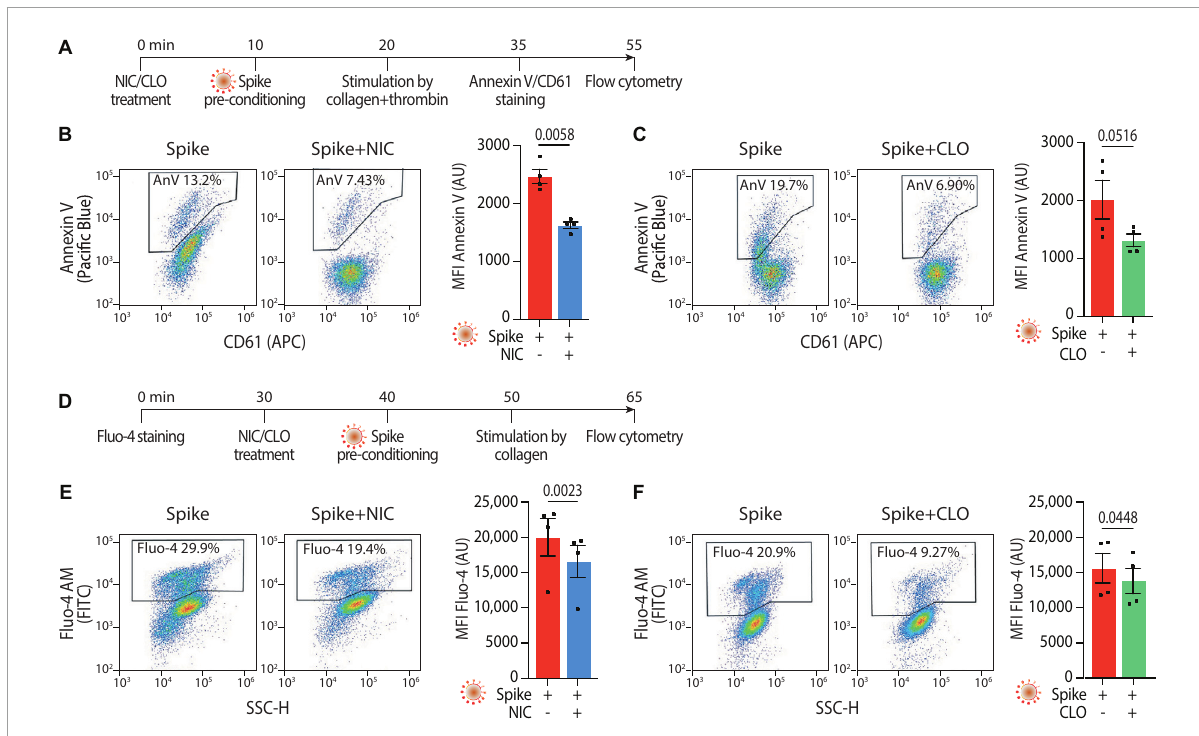
FIGURE4 Niclosamide and Clofazimine reduce annexin V reactivity and intracellular calcium in platelets. (A) Experimental scheme to assess annexin V reactivity upon Spike stimulation and drug treatment. Platelets were pre-incubated with Niclosamide (NIC, 1 µ M) or Clofazimine (CLO, 5 µ M) for 10 min, followed by incubation with collagen (30 µ g/ml) and thrombin (0.5 units) for 15 min. Platelets were then stained with Annexin V-Pacific Blue and CD61-APC and analyzed by flow cytometry. (B) Effect of Niclosamide on annexin V reactivity. Representative flow cytometry plots are on the left, quantification on the right. The boxed areas show the percentage of washed platelets positive for annexin V upon treatment with the drug or vehicle (DMSO at the same concentration and for the drug) and incubation with VSV-G or Spike pseudoparticles, followed by stimulation with collagen and thrombin. The graph shows the Mean fluorescence intensity (MFI) of annexin V positive platelets (AU, arbitrary units). Results are from n = 4 independent experiments. Data are mean ± SEM. Statistical significance is indicated (paired Student’s t -test). (C) Same as panel (B) upon treatment with Clofazimine. (D) Experimental scheme to assess Ca 2 + influx upon Spike stimulation and drug treatment. Platelets were stained with Fluo-4 for 30 min and then pre-incubated with Niclosamide (NIC, 1 µ M) or Clofazimine (CLO, 5 µ M) for 10 min, followed by incubation with collagen (30 µ g/ml) and thrombin (0.5 units) for 15 min. Platelets were then assessed for fluorescence by flow cytometry. (E) Representative flow cytometry plots are on the left, quantification on the right. The boxed areas show the percentage of washed platelets positive for Fluo-4 upon treatment with the drug or vehicle (DMSO at the same concentration and for the drug) and incubation with Spike pseudoparticles, followed by stimulation with collagen and thrombin. The graph shows the Mean fluorescence intensity (MFI) of Fluo-4 (AU, arbitrary units). Results are from n = 4 independent experiments and are expressed as mean ± SEM. Statistical significance is indicated (paired Student’s t -test). (F) Same as in panel (E) upon treatment with